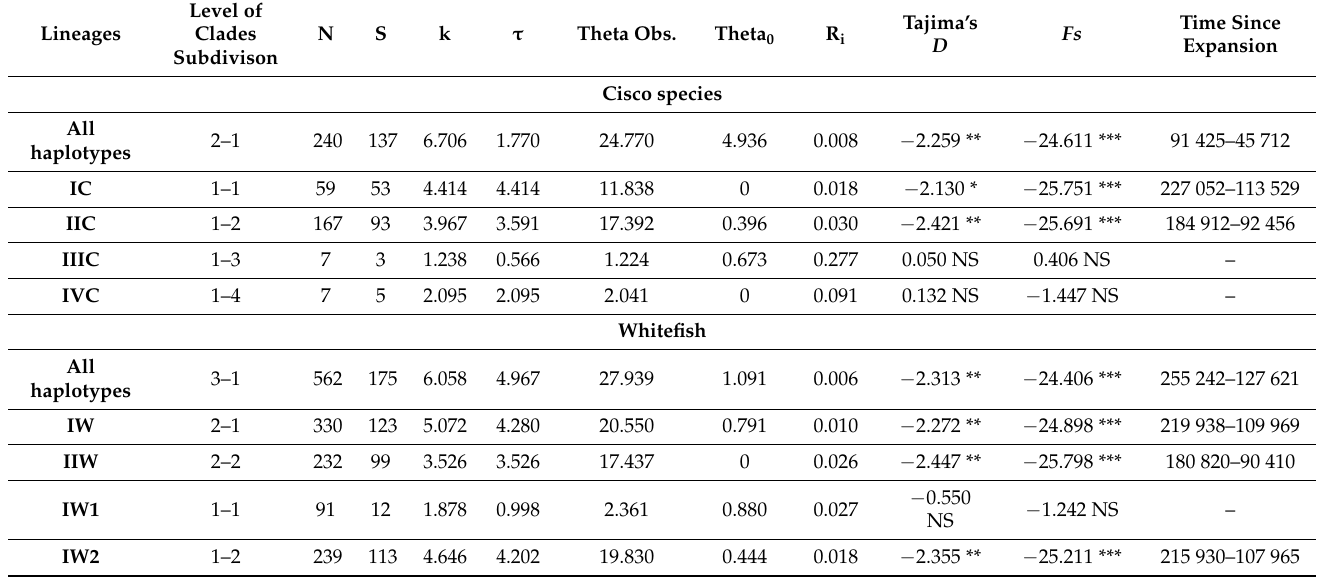
Table 2. Pairwise sequence divergence statistics (mismatch analysis) based on the frequency of haplotypes in considered cisco species ( C. albula and C. sardinella ) and whitefish ( C. lavaretus ) phylo- genetic